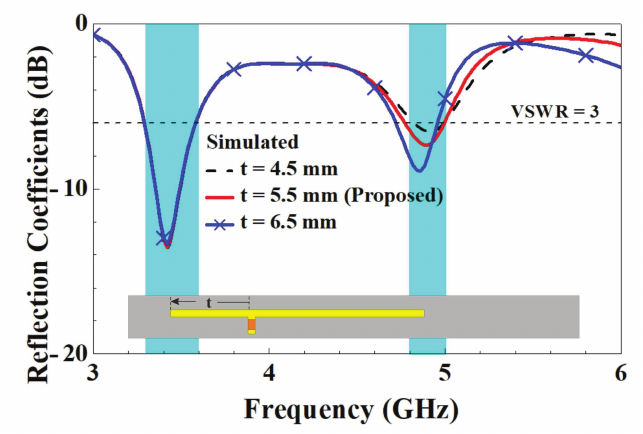
Figure 15. Comparison of simulated reflection coefficients with changes in parameter t .